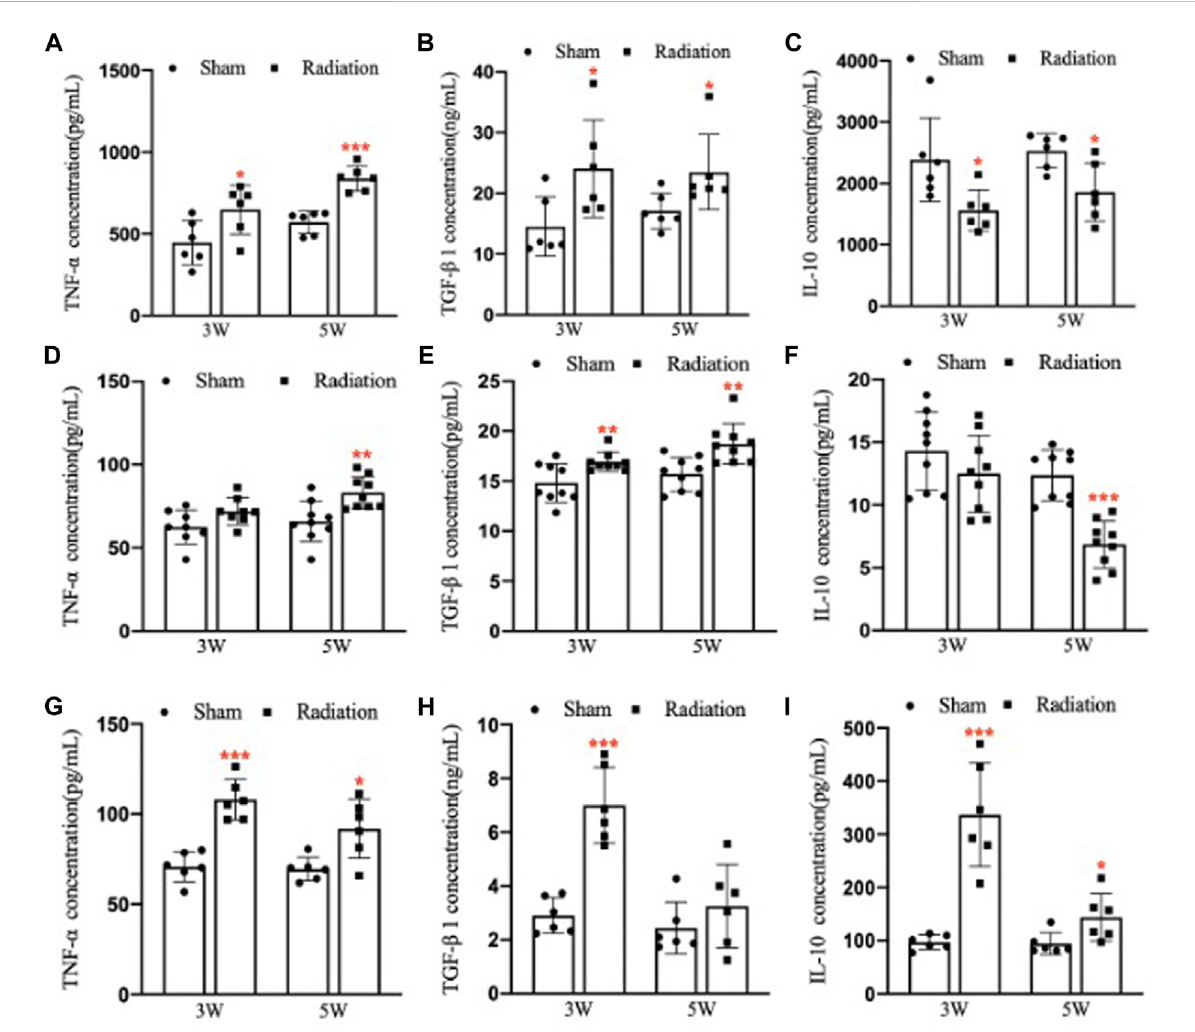
FIGURE 7 Abscopal effects of thoracic X-ray irradiation on the in fl ammatory factors in mice (A) The concentration of TNF- α in the lung of mice, n = 6 for each group. (B) The concentration of TGF- β 1 in the lung of mice, n = 6 for each group. (C) The concentration of IL-10 in the lung of mice, n = 6 for each group. (D) The concentration of TNF- α in the serum of mice, n = 9 for each group. (E) The concentration of TGF- β 1 in the serum of mice, n = 9foreachgroup. (F) TheconcentrationofIL-10intheserumofmice, n =9foreachgroup. (G) TheconcentrationofTNF- α inthetestisofmice, n = 6 for each group. (H) The concentration of TGF- β 1 in the testis of mice, n = 6 for each group. (I) The concentration of IL-10 in the testis of mice, n = 6 for each group. The values are expressed as the mean ± SD, * p < 0.01; ** p < 0.01; *** p < 0.001 vs. sham